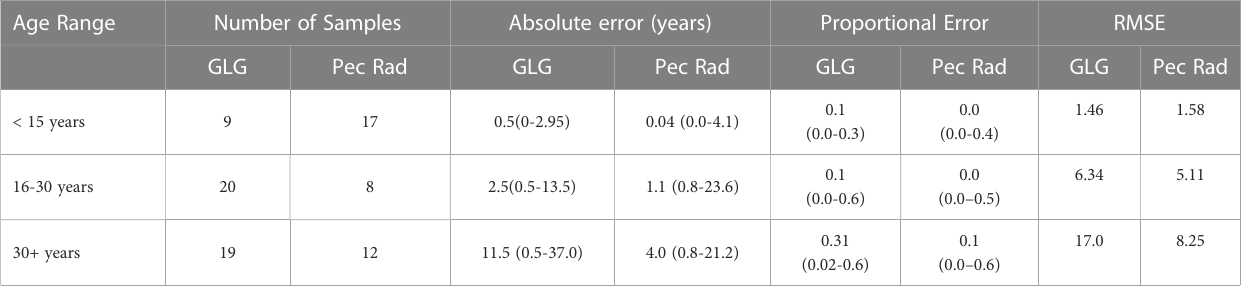
TABLE 1 Comparison of median error by age group estimated by growth layer group (GLG) analysis and pectoral fl ipper radiography (PFR). Values in parentheses are minimum and